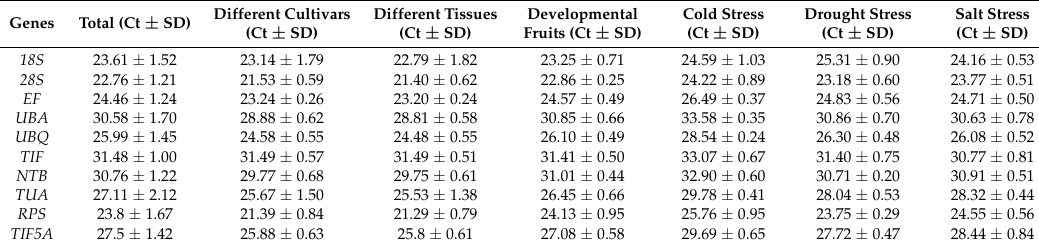
Table 2. Ct values of the ten reference genes ( 18S , 28S , EF , UBA , UBQ , TIF , NTB , TUA , RPS , and TIF5A ) as calculated for Zanthoxylum bungeanum